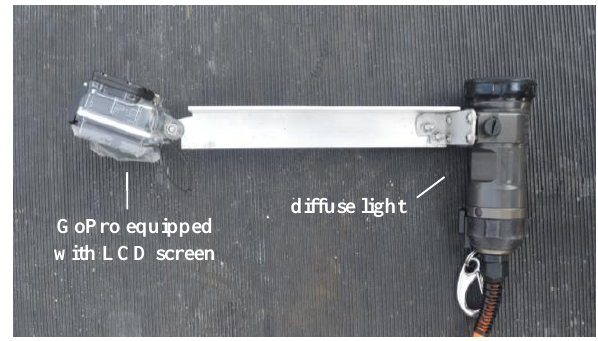
Figure 1. Basic camera setup used for